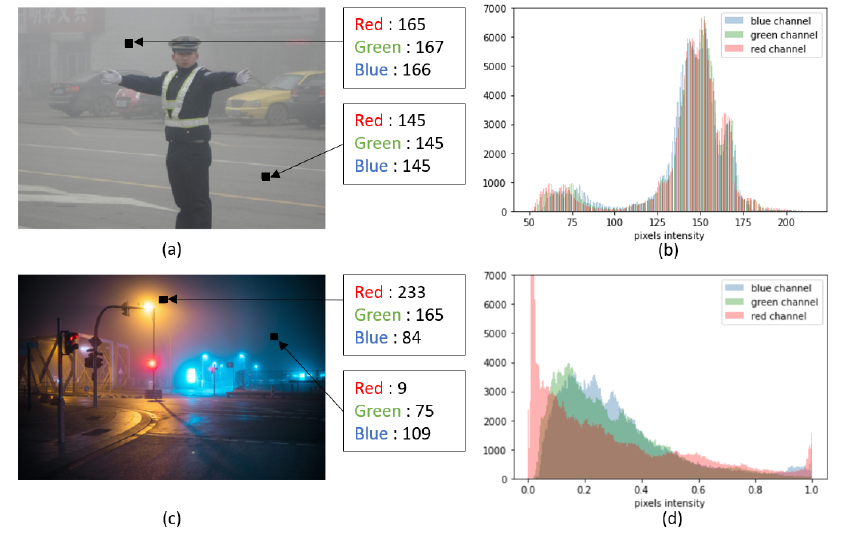
Figure 8. RGB values comparison: ( a ) daylight white fog image from the RESIDE dataset [36], ( b ) histogram of the daylight white fog image, ( c ) colored fog image (reprinted with permission from ref. [35]. Copyright 2021 Mark Broyer) , ( d ) histogram of the colored fog image. This figure shows the RGB values of the pixel in the center of the black squares. Pixel intensity is between 0 and